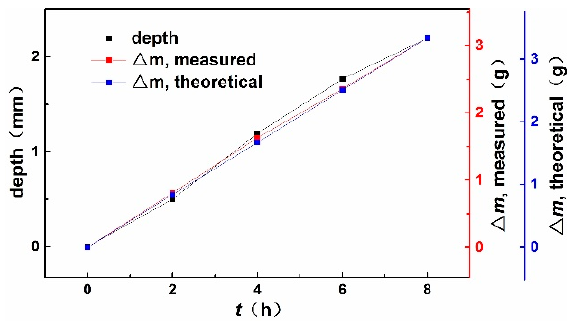
Figure 4. Variations of mass loss of the specimen ( △ m , measured and △ m , theoretical) and defect feature (depth) with corrosion time ( t ).